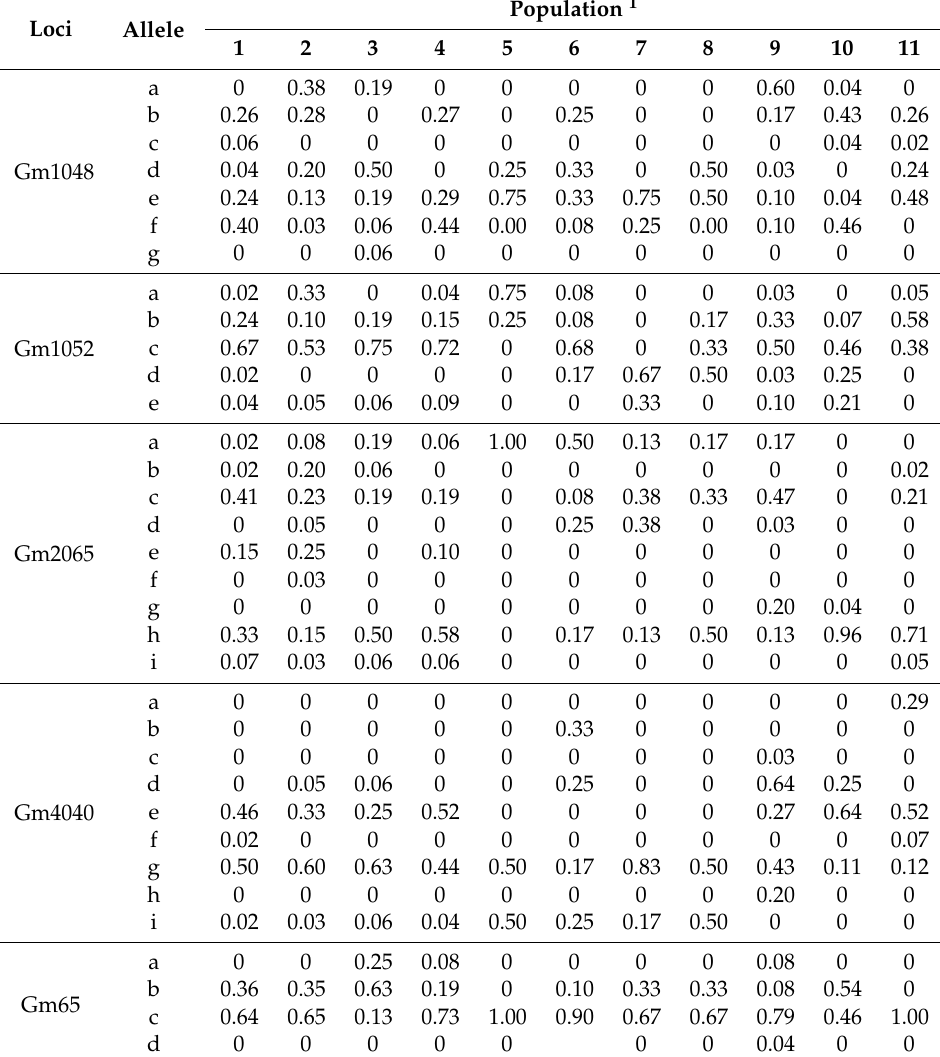
Table 2. Allele frequencies in 11 populations of Erythrophleum fordii